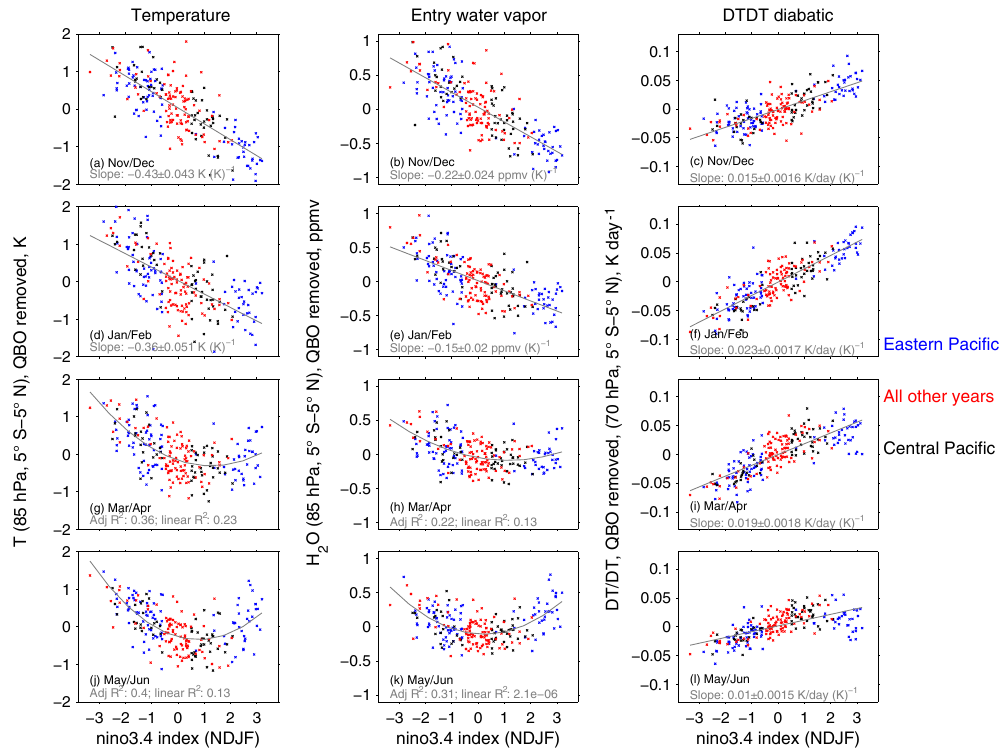
Figure 2. Seasonally resolved anomalies in the tropical lower stratosphere stratified by the Niño-3.4 index in NDJF in the coupled ocean– atmosphere GEOSCCM integration. (a–c) November and December; (d–f) January and February; (g–i) March and April; (j–l) May and June. (a, d, g, j) Temperature at 85hPa, 5 ◦ S–5 ◦ N; (b, e, h, k) water vapor at 85hPa, 5 ◦ S–5 ◦ N; (c, f, i, l) diabatic heating rate at 70hPa, 5 ◦ S–5 ◦ N. For all quantities, the data have been detrended (see Sect. 3) and the component of the variance linearly associated with the QBO at 50hPa 2 months prior has been regressed out before data are stratified by the Niño-3.4 index (see Sect. 3). Winters categorized as central Pacific ENSO are in black, eastern Pacific ENSO are in blue, and all other years in red. A least-squares best fit is shown in each panel, and the linear slope is indicated when a linear fit is deemed satisfactory (see Sect. 3). When a polynomial fit better describes the dependence on ENSO, we show the R 2 for a linear fit and adjusted R 2 for the polynomial fit (see Sect.